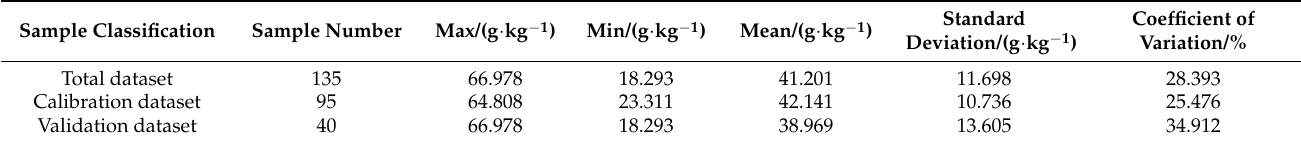
Table 1. Statistical characteristics of iron oxide